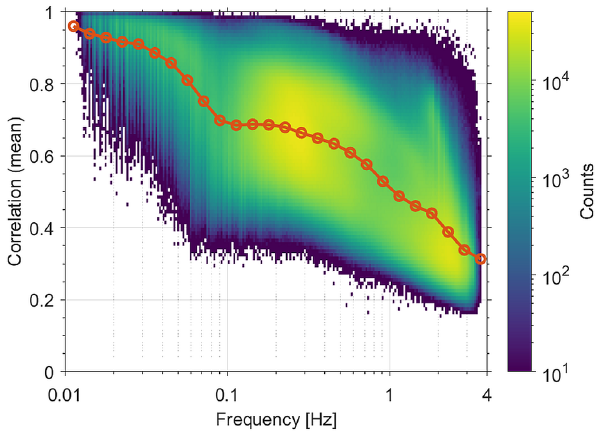
Figure 6. Correlation coefficients of all detections (2003–2020; all stations) vs. frequency. The red line depicts the mean correlation for each of the 26 frequency bands. Bin sizes are 1 / 10 of a frequency band and 0.01, respectively. The frequency-band-dependent weight- ing function w r in Eq. (1) weights the correlation coefficients of all c detections, such that the mean correlation of each frequency band would equal